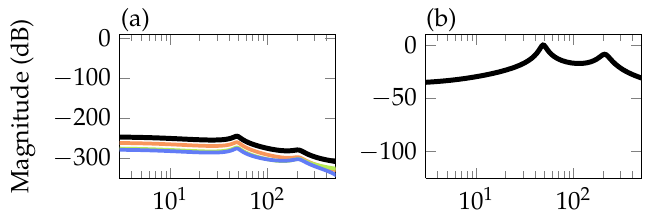
Figure 7. Bode magnitude plots from commanded deflections of inner ( ), mid ( ), outer ( ) control surfaces to residual and from pitch motor command to the residual ( ) in ( a ) and from fault to residual in ( b ).